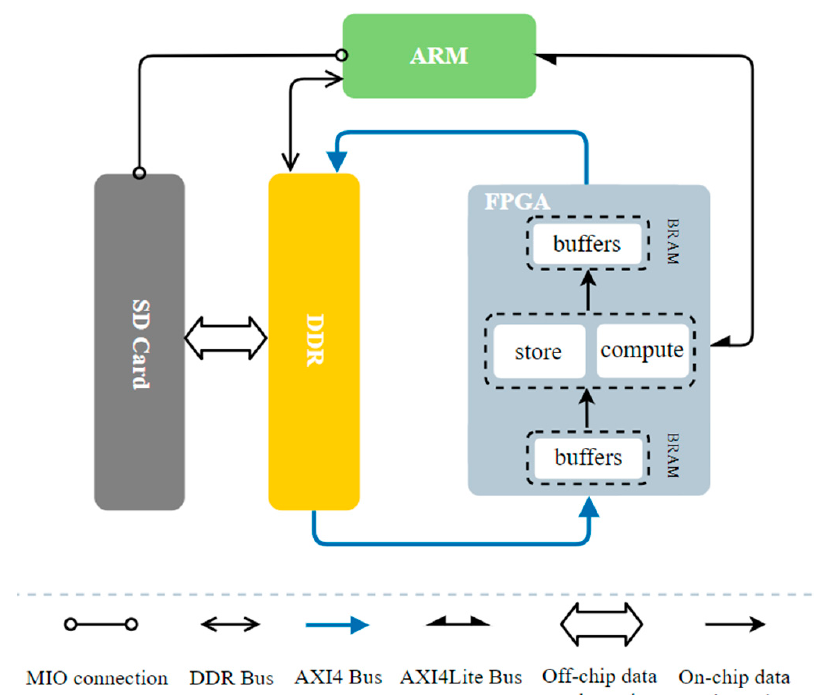
Figure 4. Hardware architecture of the chip defect detection system.